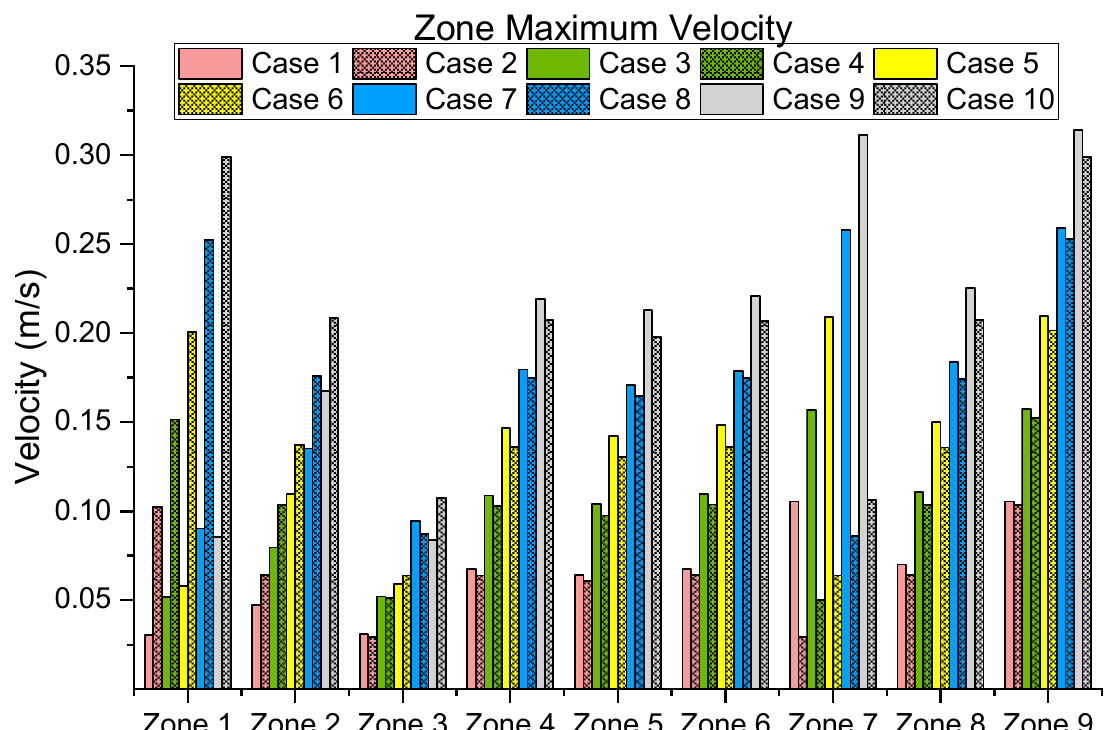
Figure 11. Shows the zone average velocity at z = 0.1 m for all cases.